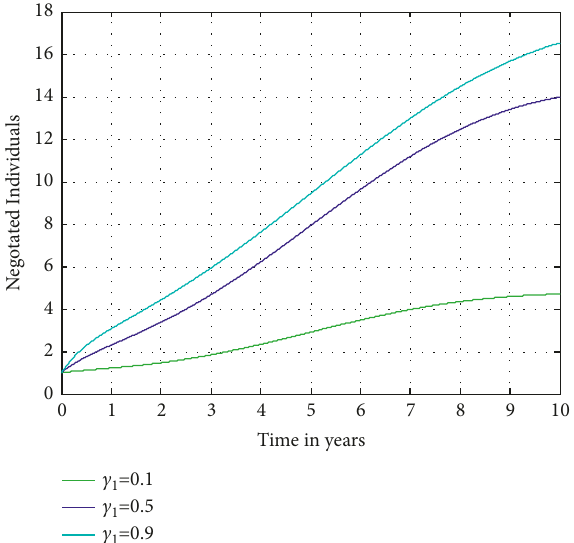
Figure 9: Effect of the negotiation rate c dividuals